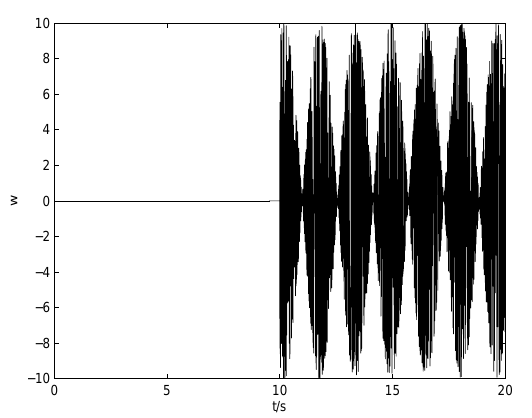
Figure 4: Time response of distance input of second order chaotic system